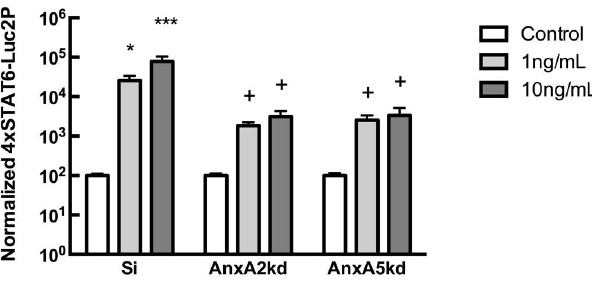
Figure 6. IL-4-induced STAT6 signaling in parental and mutant cells. Si, AnxA2 kd , or AnxA5 kd cells were transiently transfected with p4xSTAT6-Luc2P and treated with 0, 1, or 10 ng/mL IL-4 for 24 hours, after which Luciferase activity was measured. Each bar represents mean Luciferase activity 6 SEM normalized to vehicle control, n=3. *, ***represent statistically significant difference from Si control, *p , 0.05, **p , 0.01; + represents statistically significant difference compared to Siren at same IL-4 concentration, p ,